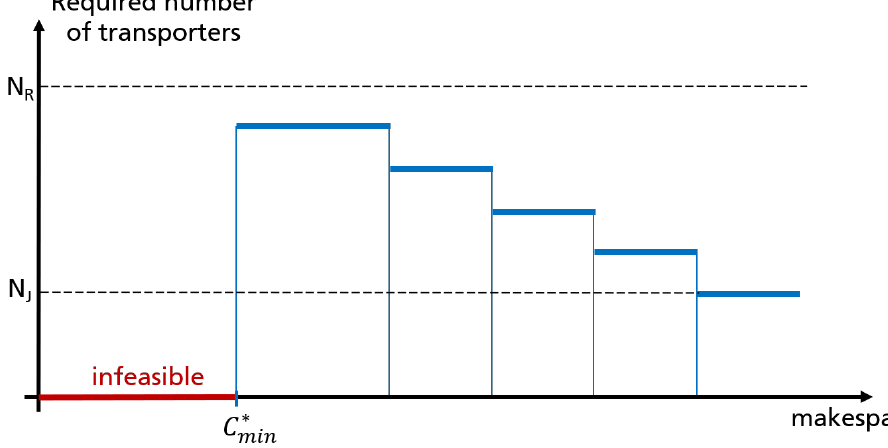
Figure 3. Minimum number of transporters in an assignment with a given makespan. A feasible solution needs at least one transporter per job. The solution minimizing the makespan does not necessarily require all N R